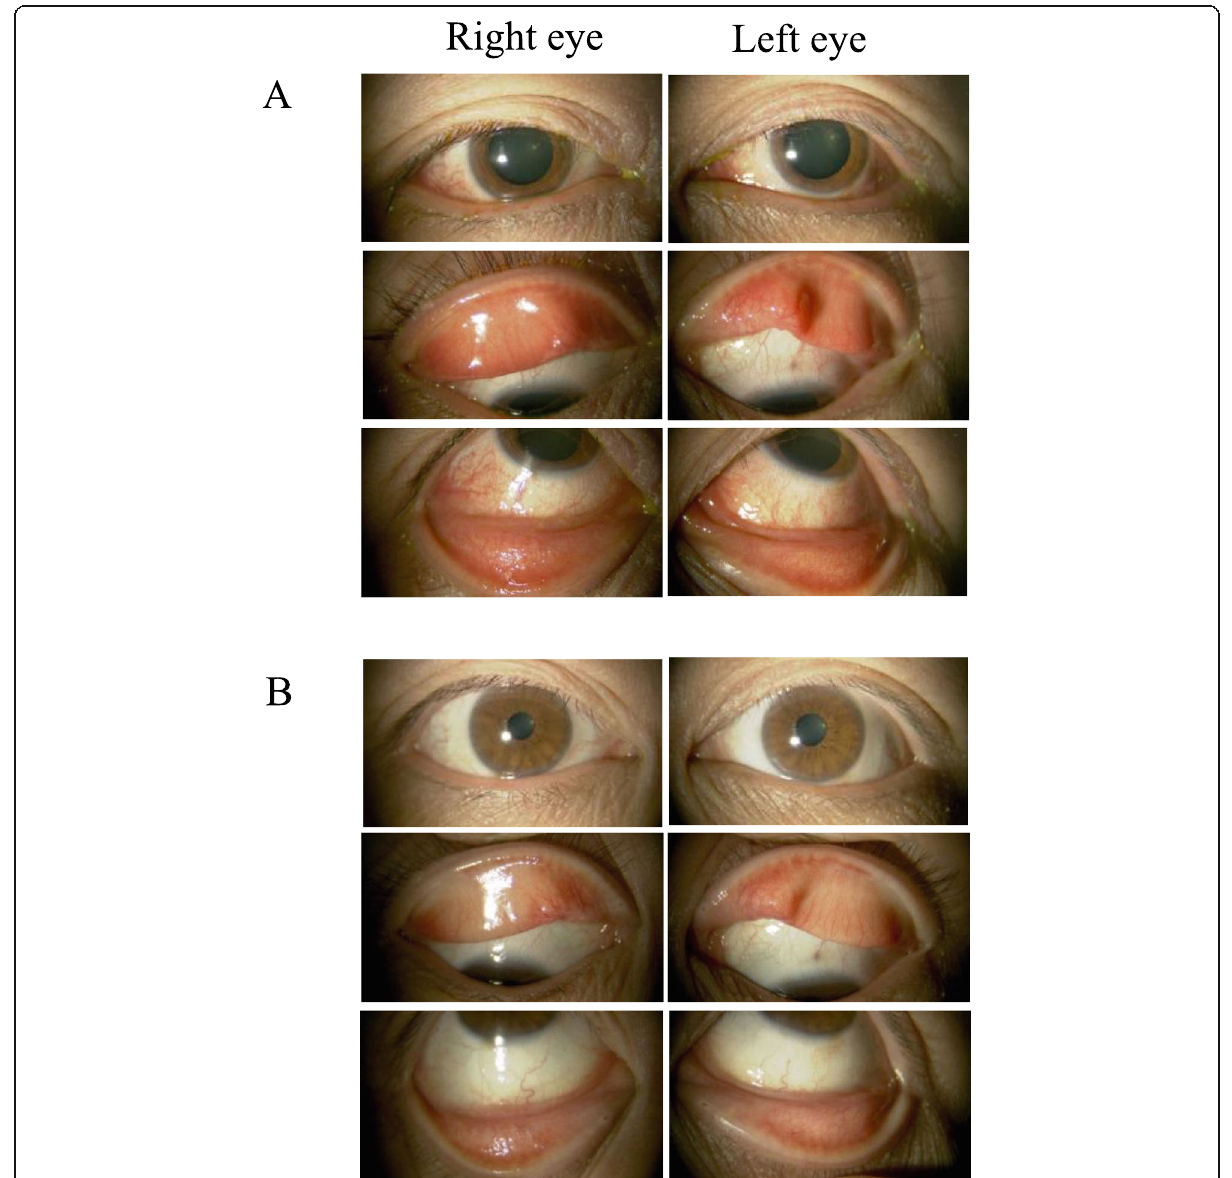
Fig. 1 Clinical findings of bilateral blepharitis and conjunctivitis after dupilumab. Bilateral blepharitis, bilateral conjunctival hyperemia, and papillary hyperplasia were observed at 10 weeks after dupilumab administration for AD ( a ). These findings disappeared at 30 weeks by treatment with 0.1% cyclosporine eye drops and 0.1% methylprednisolone ointment ( b